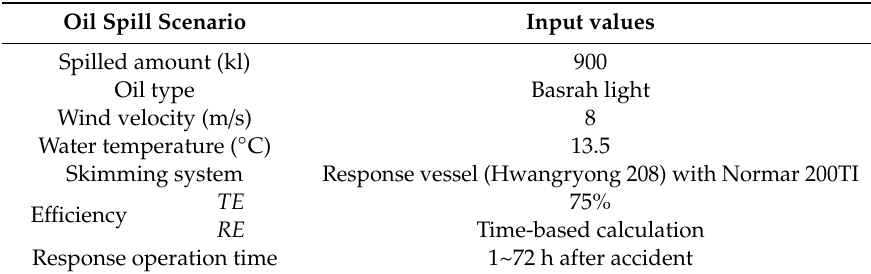
Table 2. Spill scenario input values using actual accident information.